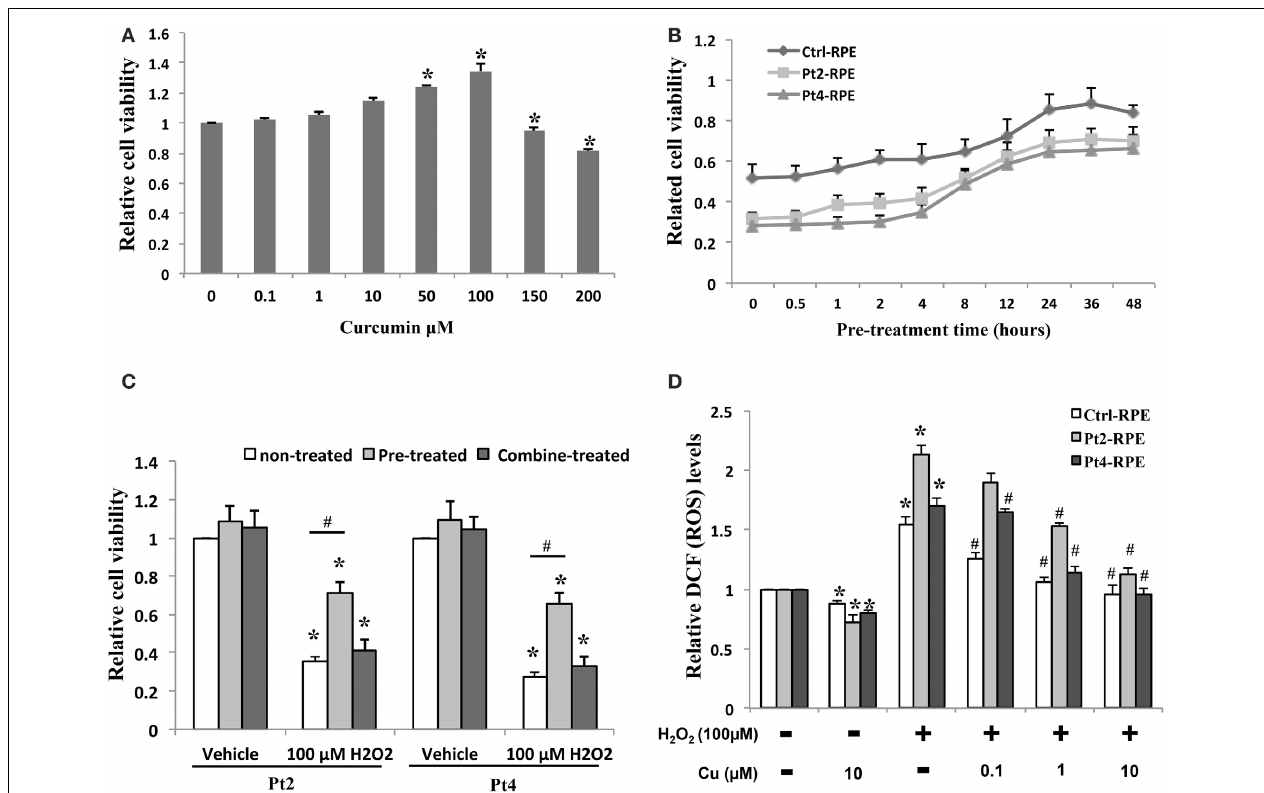
FIGURE 5 | Protective effect of curcumin on AMD-RPEs. (A) Cell viability in AMD-RPEs treatment with different concentrations of curcumin for 24h. Each bar represents the mean ± SD of three independent experiments ( ∗ p < 0 . 05, compared with non-treated control). (B) Time effect of curcumin on cells pretreated with 10 μ M curcumin at different time periods prior to 200 μ M H 2 O 2 exposure for 6h. Each bar represents the mean ± SD of three independent experiments. (C) Cell viability was measured in AMD-RPEs combine or 12h pretreated with10 μ M curcumin or treated with 10 μ M